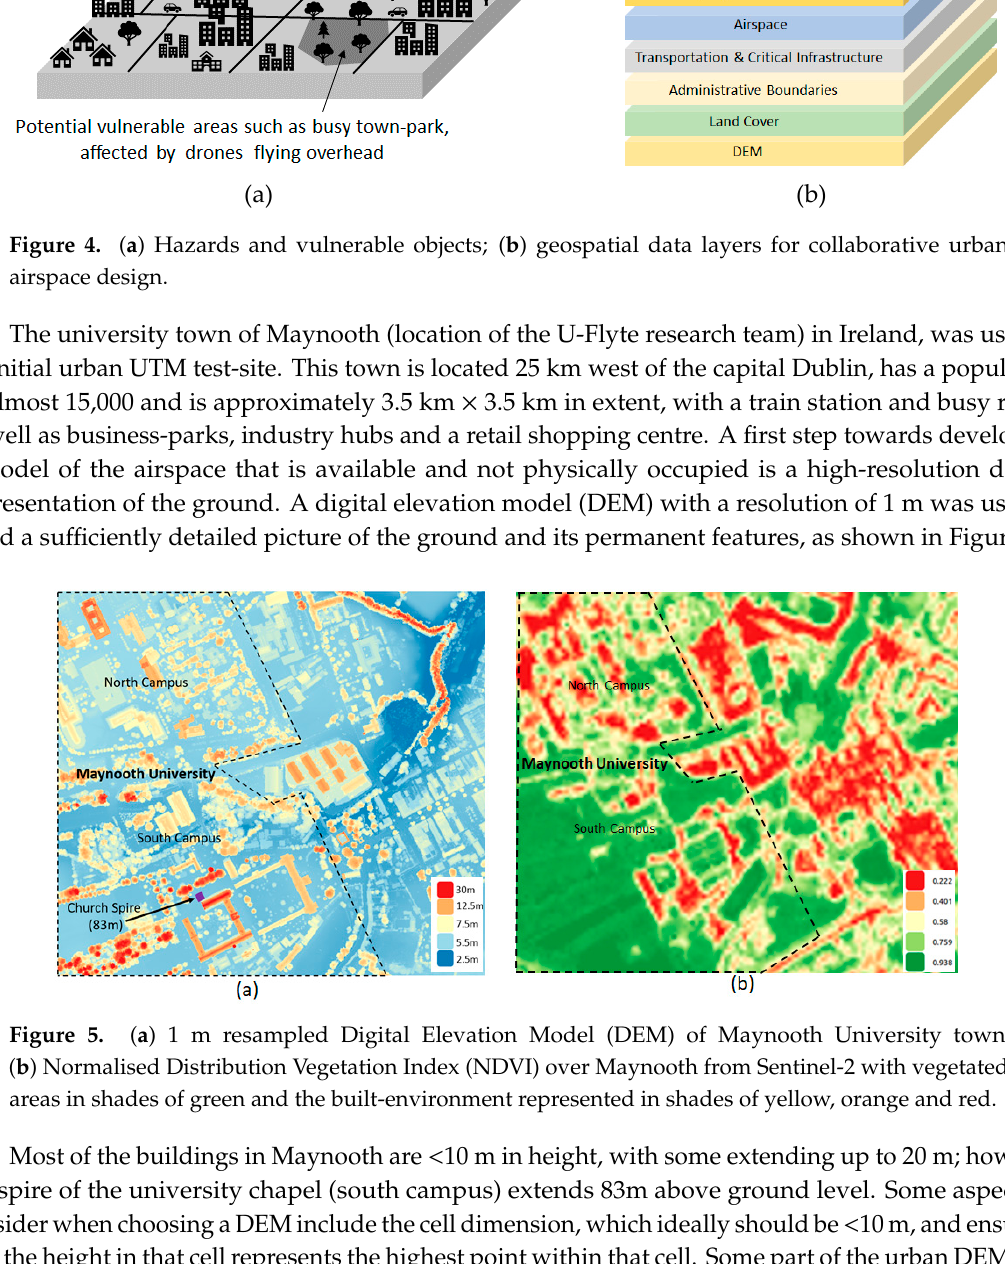
Figure 4. ( a ) Hazards and vulnerable objects; ( b ) geospatial data layers for collaborative urban airspace design.